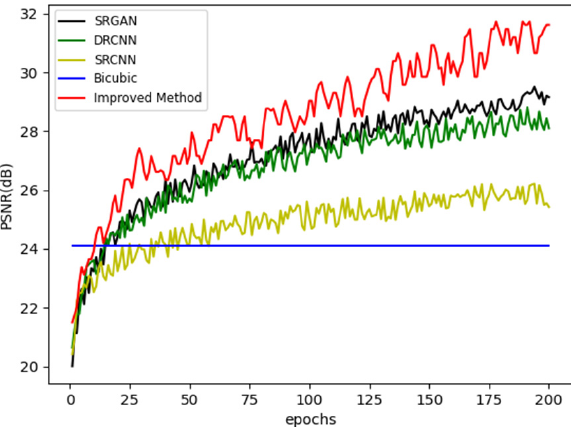
Figure 7. Comparison of different super-resolution methods.